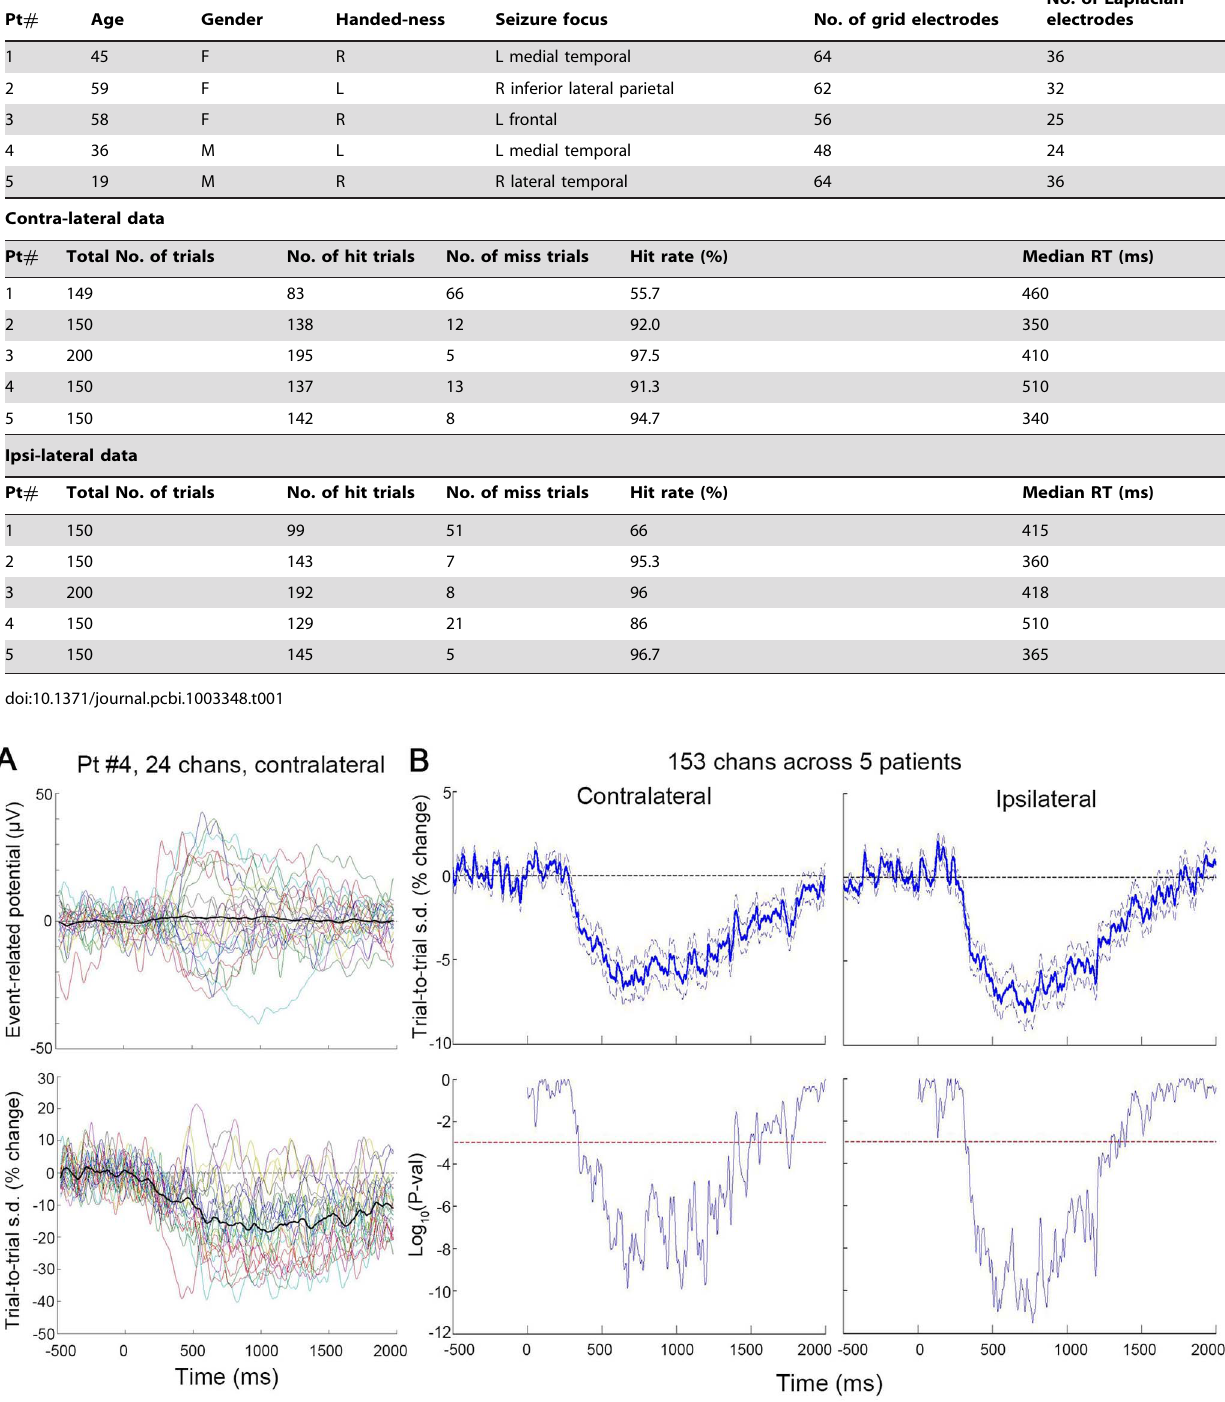
Figure 2. Reduction of trial-to-trial variability following stimulus onset. ( A ) Averaged ERPs (top) and trial-to-trial variability time courses (bottom) for all 24 Laplacian electrodes from Pt # 4 (contralateral data). The variability time course was computed as standard deviation (s.d.) across trials, normalized to the mean of the pre-stimulus period ( 2 500 , 0 ms) and expressed in %change unit. Thick black traces denote the average across 24 electrodes. ( B ) Top: Trial-to-trial variability time course averaged across all 153 Laplacian electrodes in five subjects. Dashed lines depict mean 6 SEM. Bottom: Significance of the variability time course, assessed by a one-sample t-test across 153 electrodes against the null hypothesis of no change from baseline. The left column is obtained using contralateral data, and the right column using ipsilateral data. Red dashed lines indicate significance level of P=0.001.